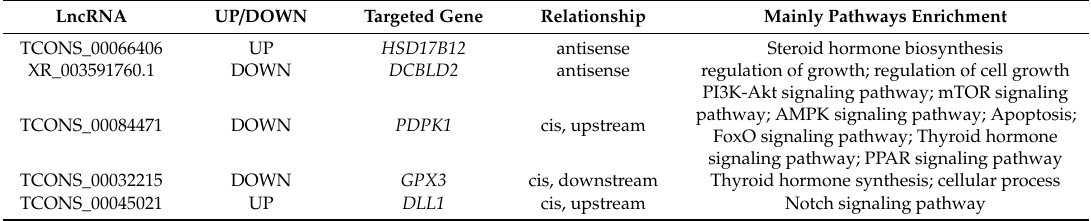
Table 1. Five candidate long noncoding RNAs (lncRNAs) and their targeted genes.